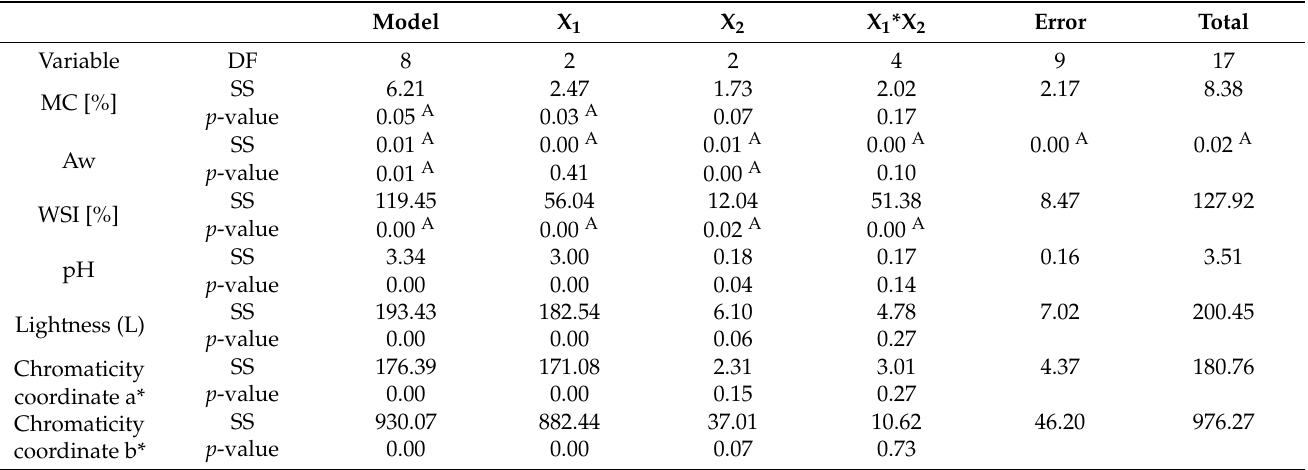
Table 4. Results of the ANOVA variance analysis for the physicochemical properties of liquid egg components that are processed into dried powders.